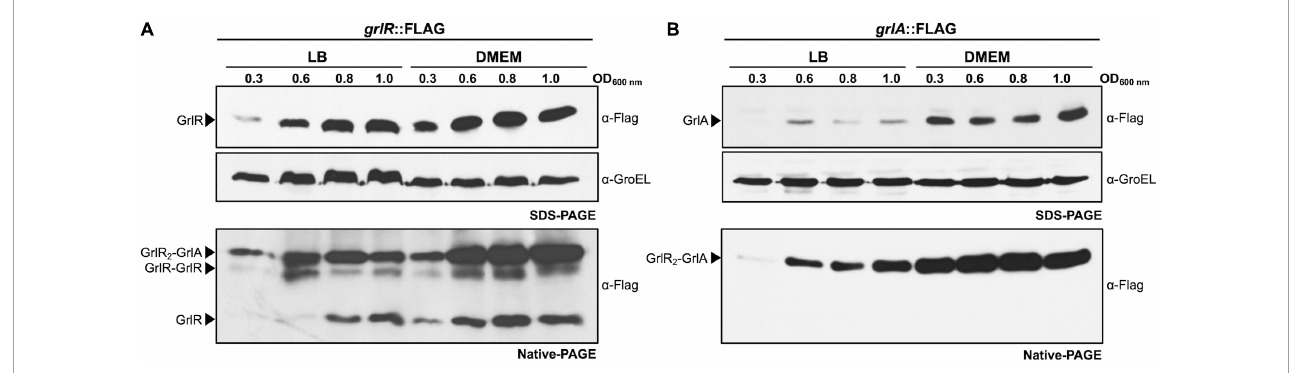
FIGURE8 GrlR and GrlA are expressed under both repressing and inducing conditions and interact to form the GrlR 2 -GrlA heterotrimer. The enteropathogenic Escherichia coli (EPEC) grlR :3xFLAG (A) and grlA :3xFLAG (B) strains were grown in 50 ml of Dulbecco’s modified Eagle’s medium (DMEM) or Lysogeny Broth (LB) with shaking at 37 ◦ C. Total cell extracts were collected at OD 600 of 0.3, 0.6, 0.8, and 1.0 and separated by 12% native PAGE. GrlR 2 -GrlA and GrlR-GrlR complexes and GrlR monomer are indicated by arrows and were identified by western blotting using anti-FLAG monoclonal antibodies. The same cell extracts were also separated by 12% SDS-PAGE to evaluate the expression of GrlR-FLAG and GrlA-FLAG by western blotting using anti-FLAG antibodies. As a control for protein loading, GroEL expression was also analyzed using anti-GroEL